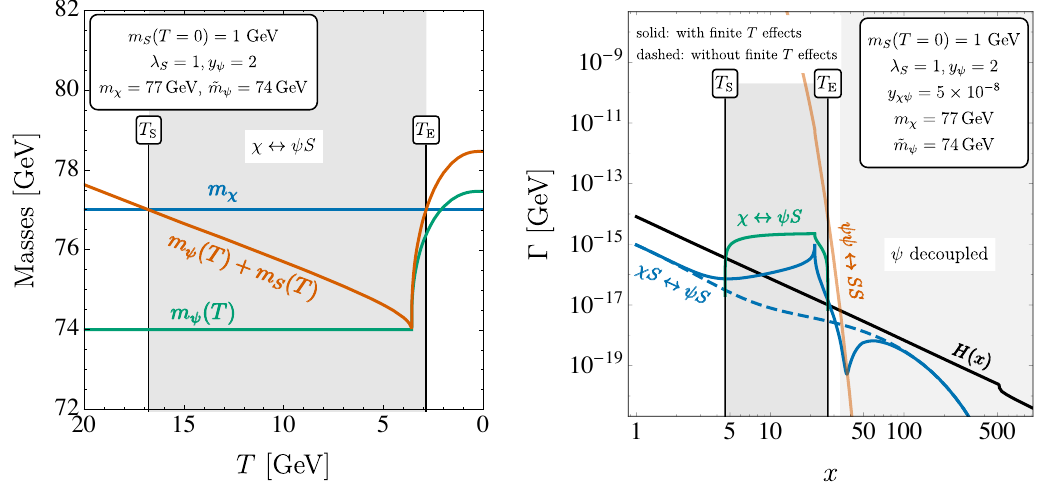
Figure 8 . Left: the masses of (cid:31) and as a function of temperature, along with the period where the channel (cid:31) $ S is kinematically allowed. Right: the rates of processes which at some x are larger than the Hubble expansion rate, H . In dashed blue we show the rate of (cid:31)S $ S if (cid:12)nite temperature e(cid:11)ects are ignored. In light grey we show the period where is decoupled from the thermal